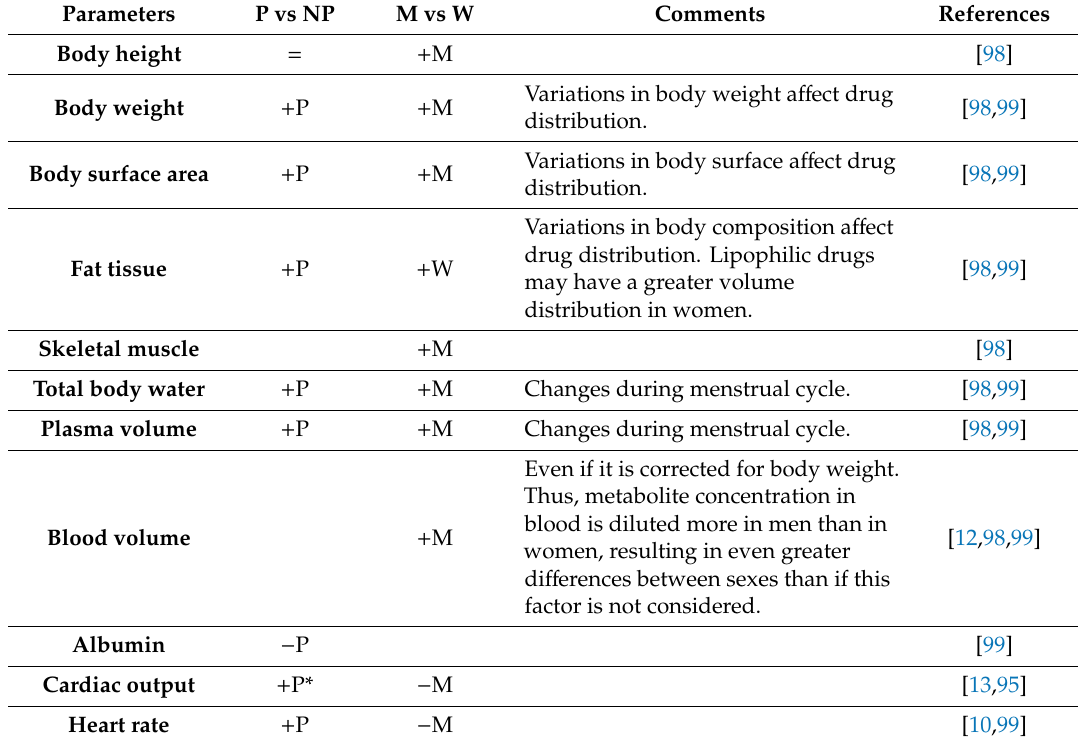
Table 3. Physiological di ff erences between men and women. Plus ( + ) indicates a greater extent in a certain sex–gender with respect to the other, or in P (pregnant women) versus NP (non-pregnant women). Minus (–) indicates a lesser extent in a certain sex–gender with respect to the other, or in